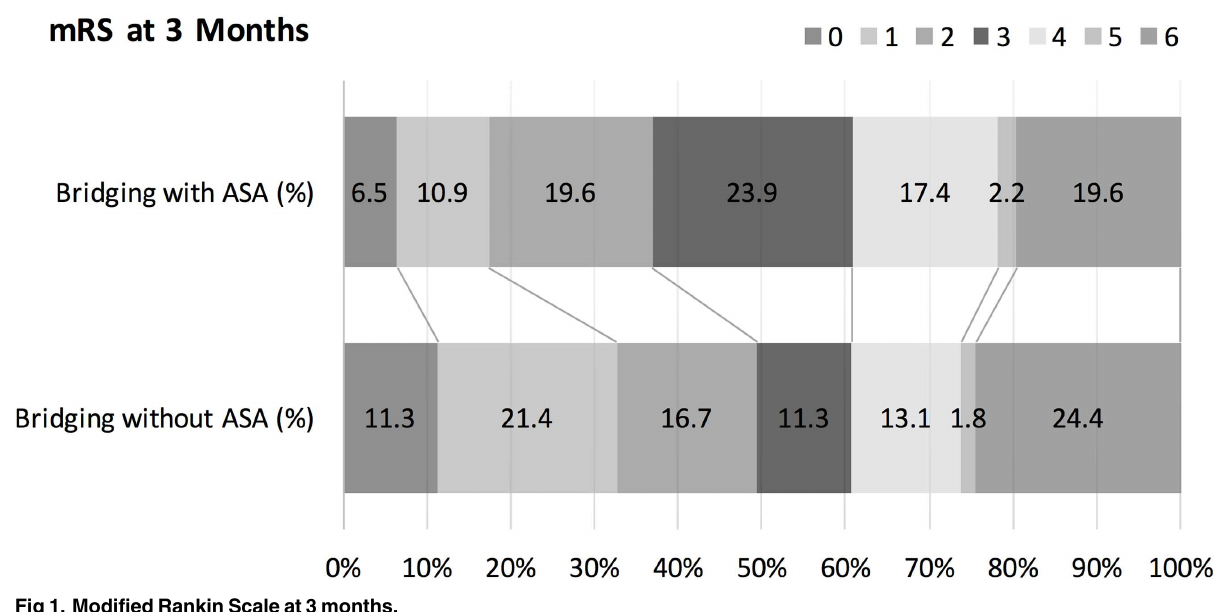
Fig 1. Modified Rankin Scale at 3